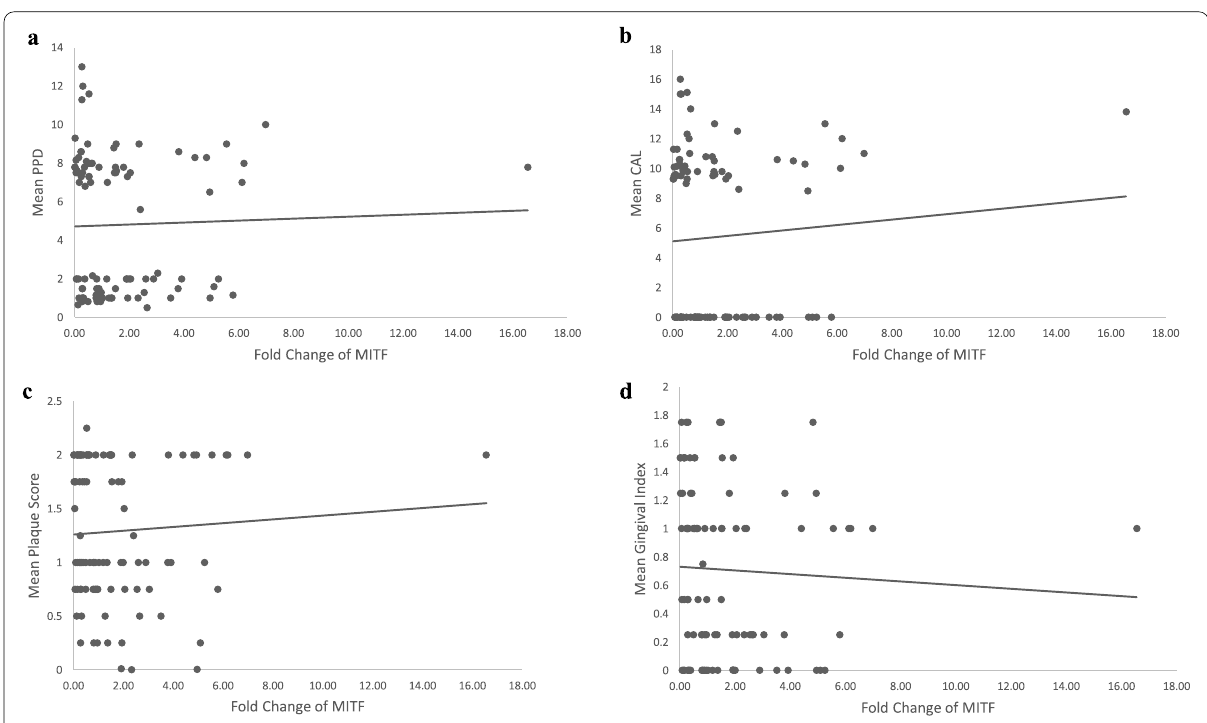
Fig. 3 a Scatter plot showing the correlation between fold change of MITF gene expression with site-specific mean PPD in 98 subjects. b Scatter plot showing the correlation between fold change of MITF gene expression with site-specific mean CAL in 98 subjects. c Scatter plot showing the correlation between fold change of MITF gene expression with site-specific mean Plaque score in 98 subjects. d Scatter plot showing the correlation between fold change of MITF gene expression with site-specific mean Gingival Index Score in 98